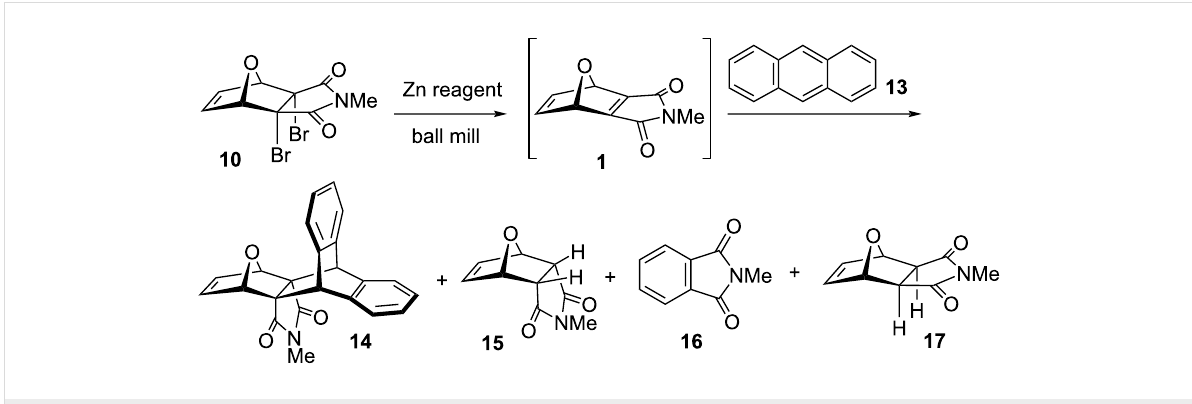
Scheme 1: Mechanochemical reaction of 10 with anthracene.